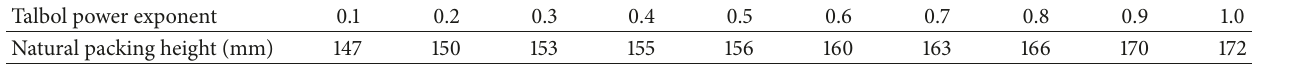
Table 2: The natural packing height (mm) of tested samples with different Talbols.